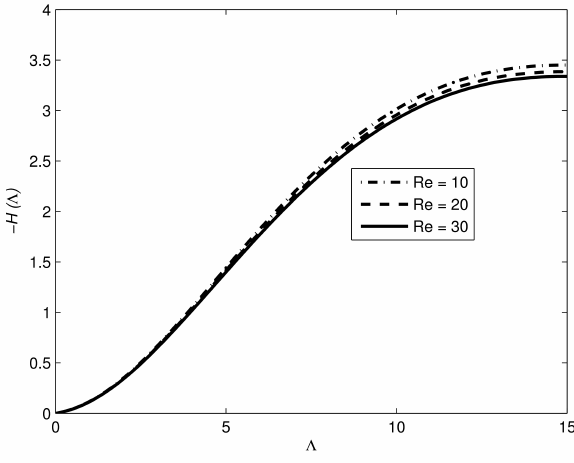
Figure 15: Effect of Re on − H ( Λ ) keeping ζ = 0.5 , η = 0.2 , C 1 = C 2 = C 3 = 50 , Pr = 6.8 , and Br = 5